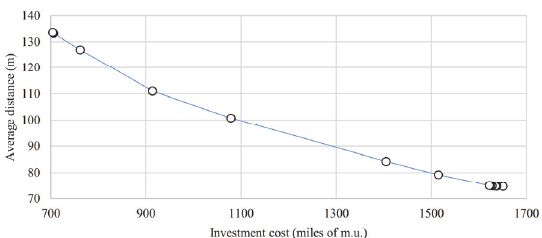
Fig. 5. Pareto front of the third scenario. Number of grid points = 20. Multi-objective approach = weighted-sum